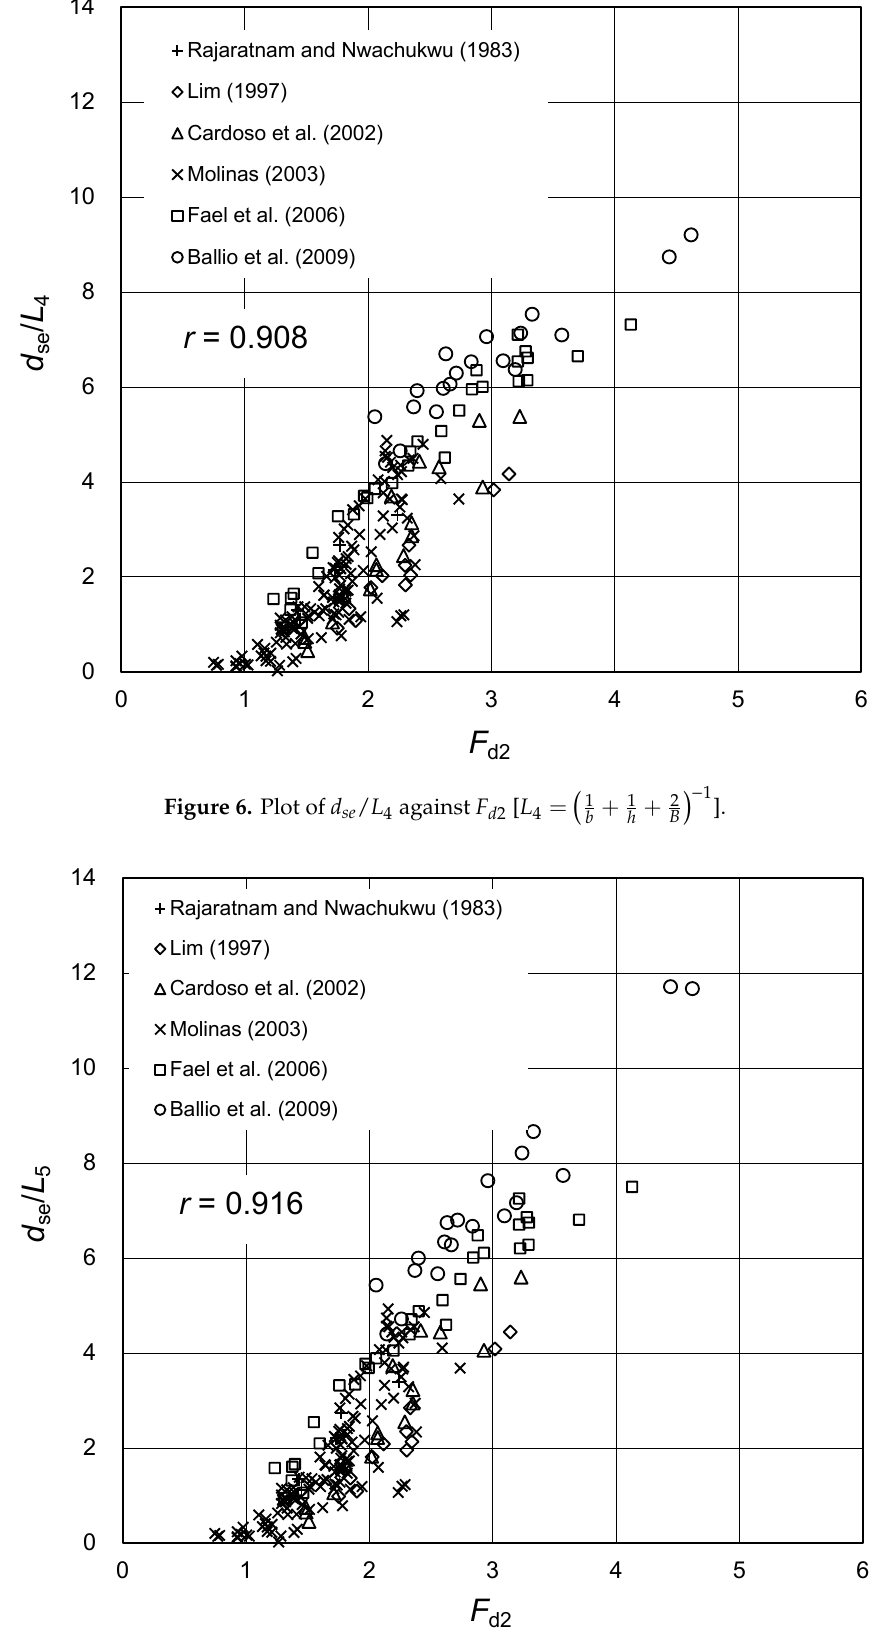
(cid:16) (cid:17) − 1 1 + 1 + 2 (cid:2879)(cid:2869) b h B − b (cid:2869) (cid:2869) (cid:2870) = (cid:4672) + + (cid:4673) [ (cid:1838) ]. (cid:3031)(cid:2870) (cid:2873) (cid:3029) (cid:3035) (cid:3003)(cid:2879)(cid:3029)